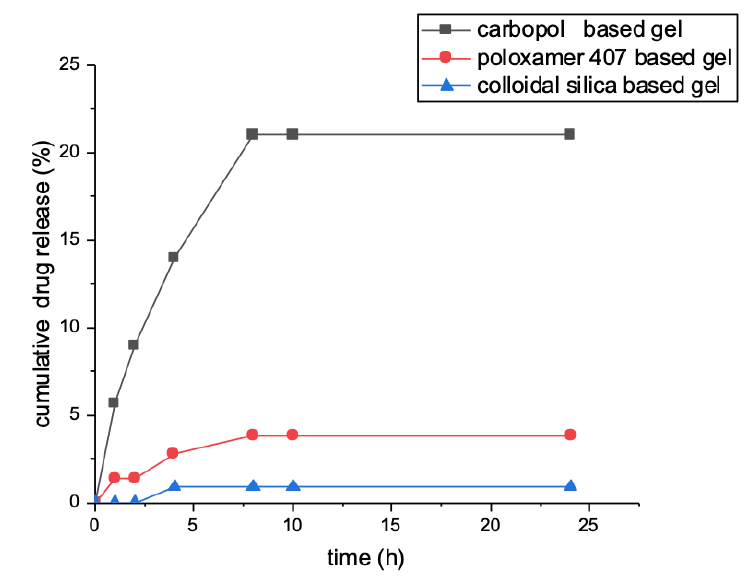
Figure 3. Cyclosporine release profile evaluated within 24 h.